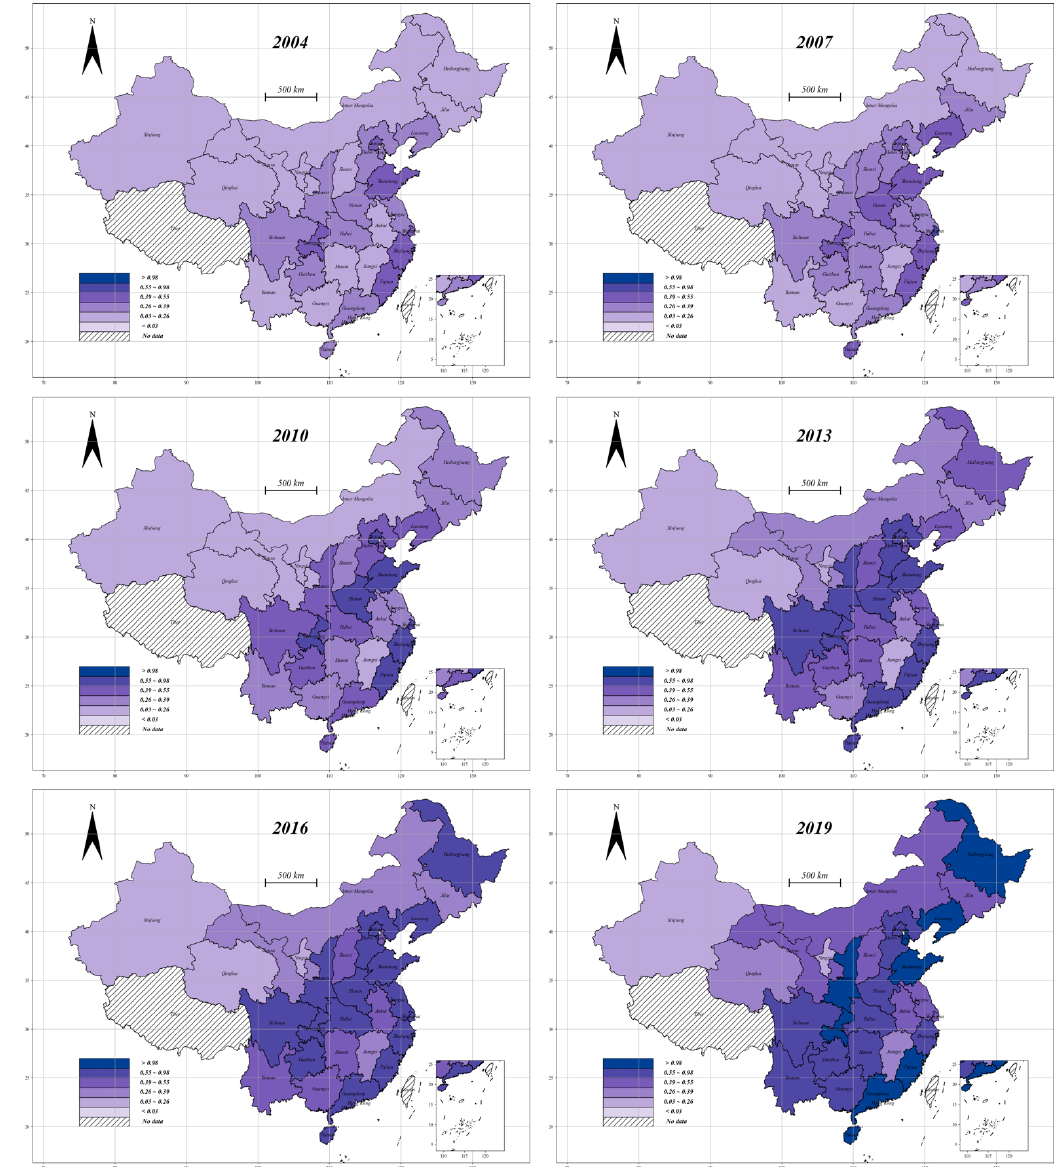
Figure 3. Spatial distribution of irrigation water efficiency in China. Table 1. Summary statistics of agricultural production input and output.